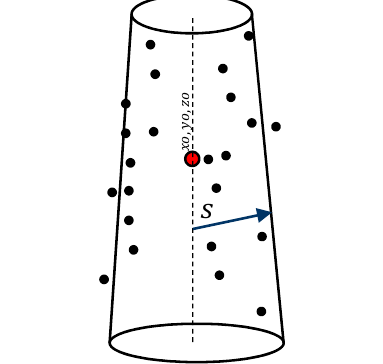
Figure 3. Fitting points to a cone defined by eight parameters.